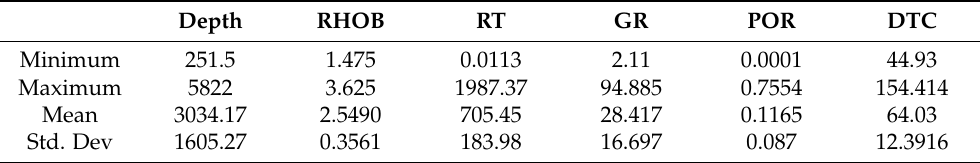
Table 4. Dataset information from P3 well (Total = 15,025).